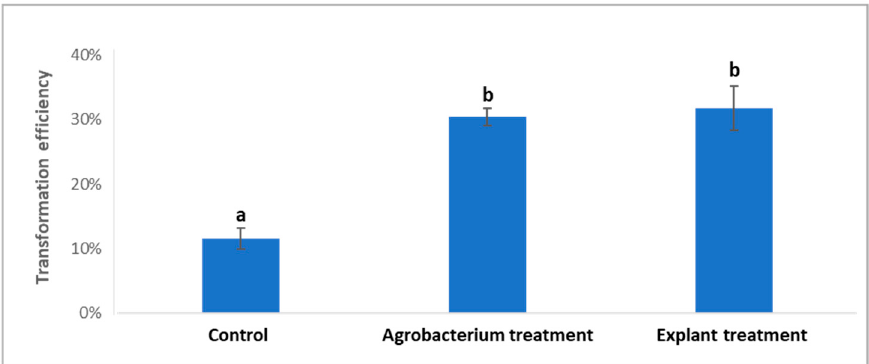
Figure 2. Treatments of Agrobacterium and epicotyl explants of ‘Carrizo’ citrange prior to co-cultivation increased citrus transformation efficiencies. The different letters represent significant difference among different treatments ( p < 0.05, ANOVA, Tukey/LSD).